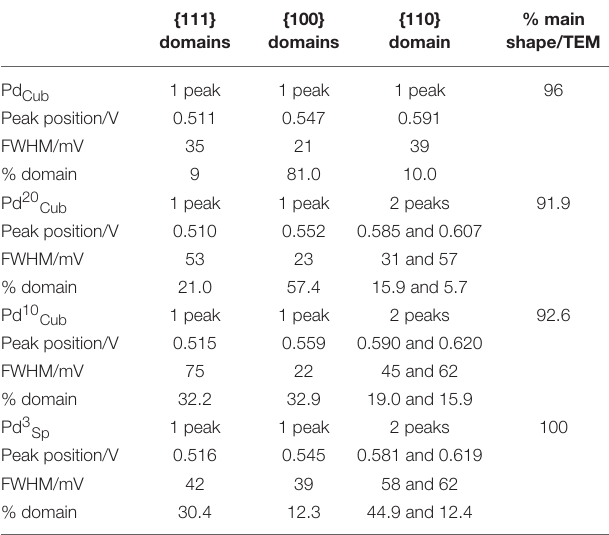
TABLE 4 | Main results of the deconvolution process of the Cu UPD voltammograms on (a) Pd Cub , (b) Pd 20 Cub , (c) Pd 10 Cub , and (d) Pd 3 Sp nanoparticles shown in Figure 8